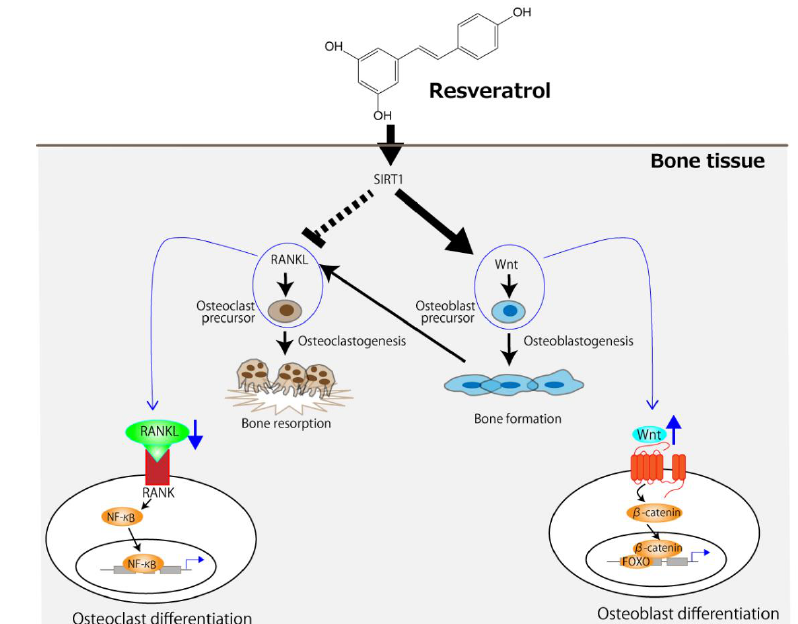
Figure 1. The proposed molecular-level mechanism underlying the improvement of OVX-induced osteoporosis by resveratrol centered on SIRT1. The arrows and the dotted line indicate stimulation and suppression, respectively. FOXO, forkhead box protein.